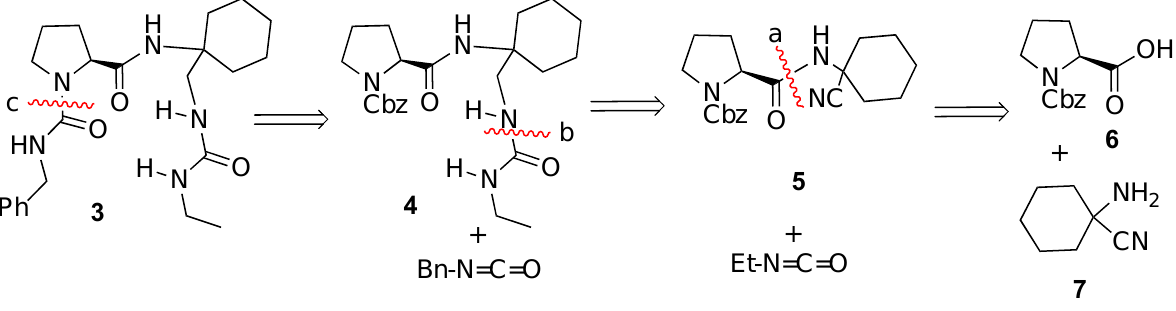
Scheme 1. Synthetic plan for target 3.